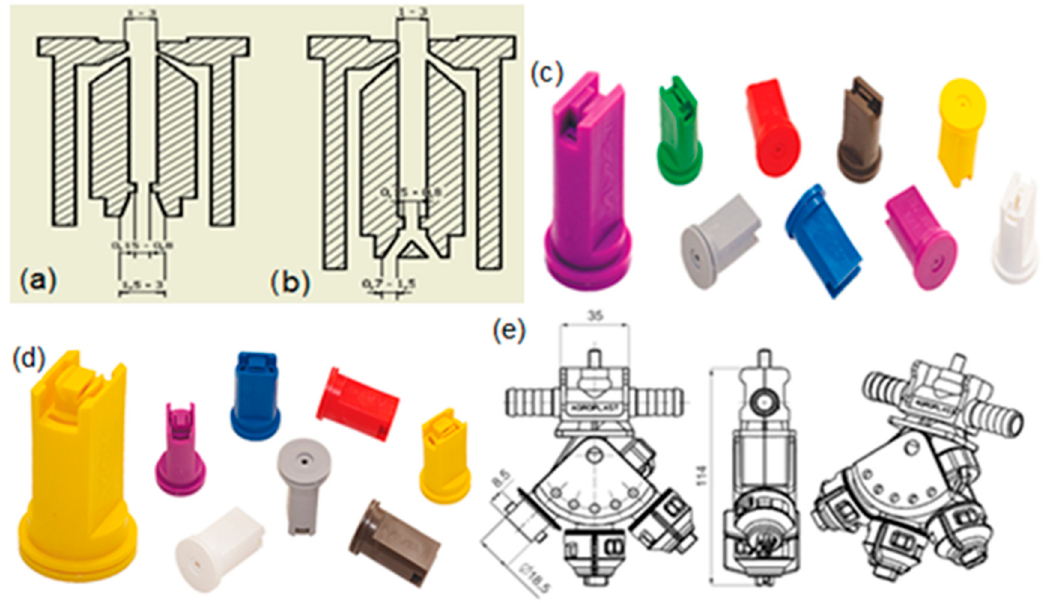
Figure 1. Overview picture: ( a ) cross-section of the E Ż K compact air induction nozzle, ( b ) cross-section of the E Ż KT compact twin jet air induction nozzle, ( c ) E Ż K compact single jet air induction nozzle, ( d ) E Ż KT compact twin jet air induction nozzle, ( e ) structure of the nozzle body [16].